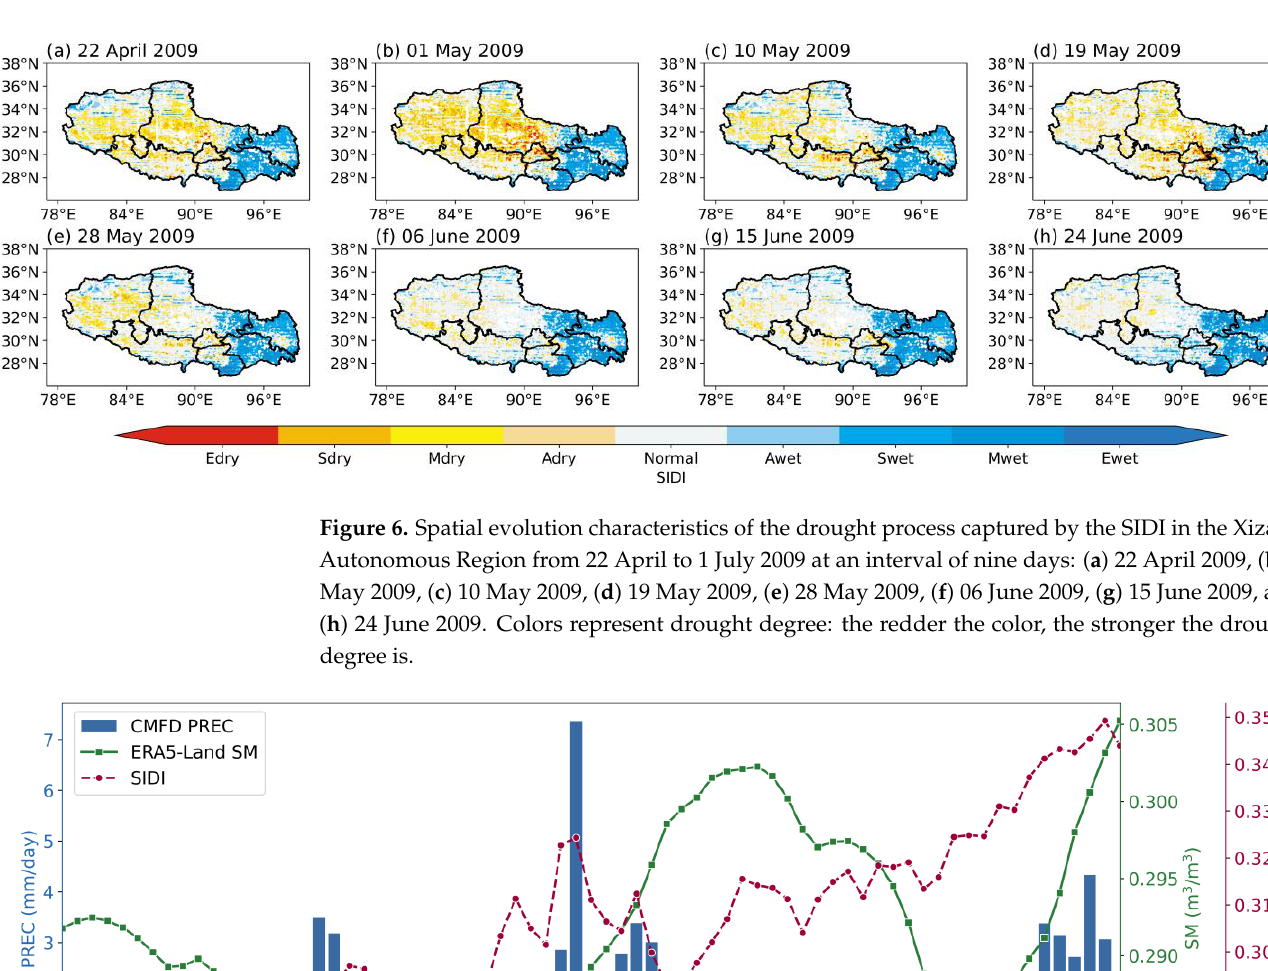
Figure 6. Spatial evolution characteristics of the drought process captured by the SIDI in the Xizang Autonomous Region from 22 April to 01 July 2009 at an interval of nine days: ( a ) 22 April 2009, ( b ) 01 May 2009, ( c ) 10 May 2009, ( d ) 19 May 2009, ( e ) 28 May 2009, ( f ) 06 June 2009, ( g ) 15 June 2009, and ( h ) 24 June 2009. Colors represent drought degree: the redder the color, the stronger the drought degree is.